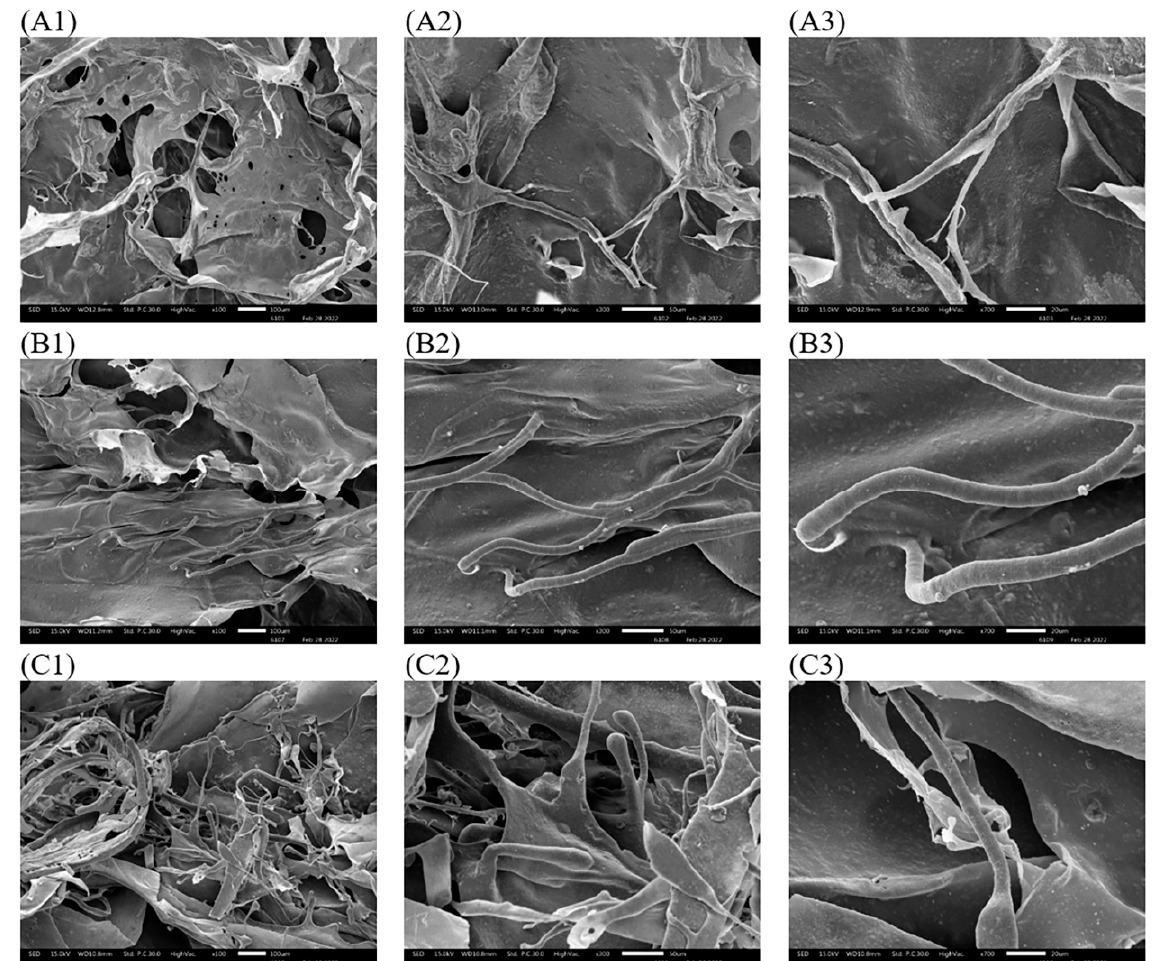
Figure 4. Surface microstructure of tuna-tendon collagens as VTC (acid-solubilized collagen using vinegar extraction) × 100 ( A1 ), × 300 ( A2 ), × 700 ( A3 ); ATC (acid-solubilized collagen using acetic acid extraction) × 100 ( B1 ), × 300 ( B2 ), × 700 ( B3 ); APTC (pepsin-solubilized collagen) × 100 ( C1 ), × 300 ( C2 ), × 700 ( C3 ).